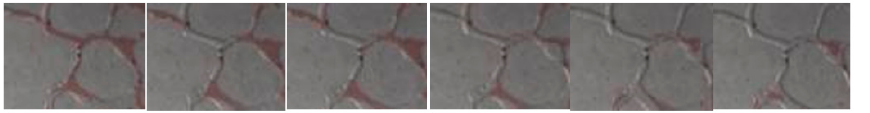
When the displacement rate increases from 0.05 mL/min (when the cumulative PV number is 5.1) to 0.1 mL/min (when the cumulative PV number is 11.2), it can be seen that the displacement efficiency increases significantly, and about half of the remaining oil is displaced. The other half of the branched remaining oil is dispersed to form the remaining columnar oil. When the displacement rate increases to 0.2 mL/min (i.e., when the cumulative PV number is 20.7), the displacement effect does not increase significantly. When the displacement rate continues to increase to 0.3 mL/min (i.e., when the cumulative PV number is 39.2), the displacement efficiency increases significantly at the end of the displacement stage, and most of the remaining columnar oil is displaced. Only a few columnar remaining oils are not driven. A small amount of drop-like remaining oil is Energies 2022 , 15 , x FOR PEER REVIEW 15 of 20 formed in this process. When the displacement rate is increased to 0.4 mL/min (i.e., the cumulative PV number is 56.6), the displacement efficiency still increases significantly. The remaining columnar oil is displaced, and the rest is the drop-like remaining oil formed after displacement. When the displacement rate is increased to 0.5 mL/min (i.e., the cumulative PV number is 80.0), the displacement efficiency increases significantly. The displacement efficiency does not increase, which indicates that the drop-like remaining oil cannot be easily driven (see Figure 13). When the water injection rate increases from 0.05 to 0.5 mL/min, the branched remaining oil area decreases from 0.661 to 0.042 mm 2 . The oil displacement efficiency was increased by 93.67%.